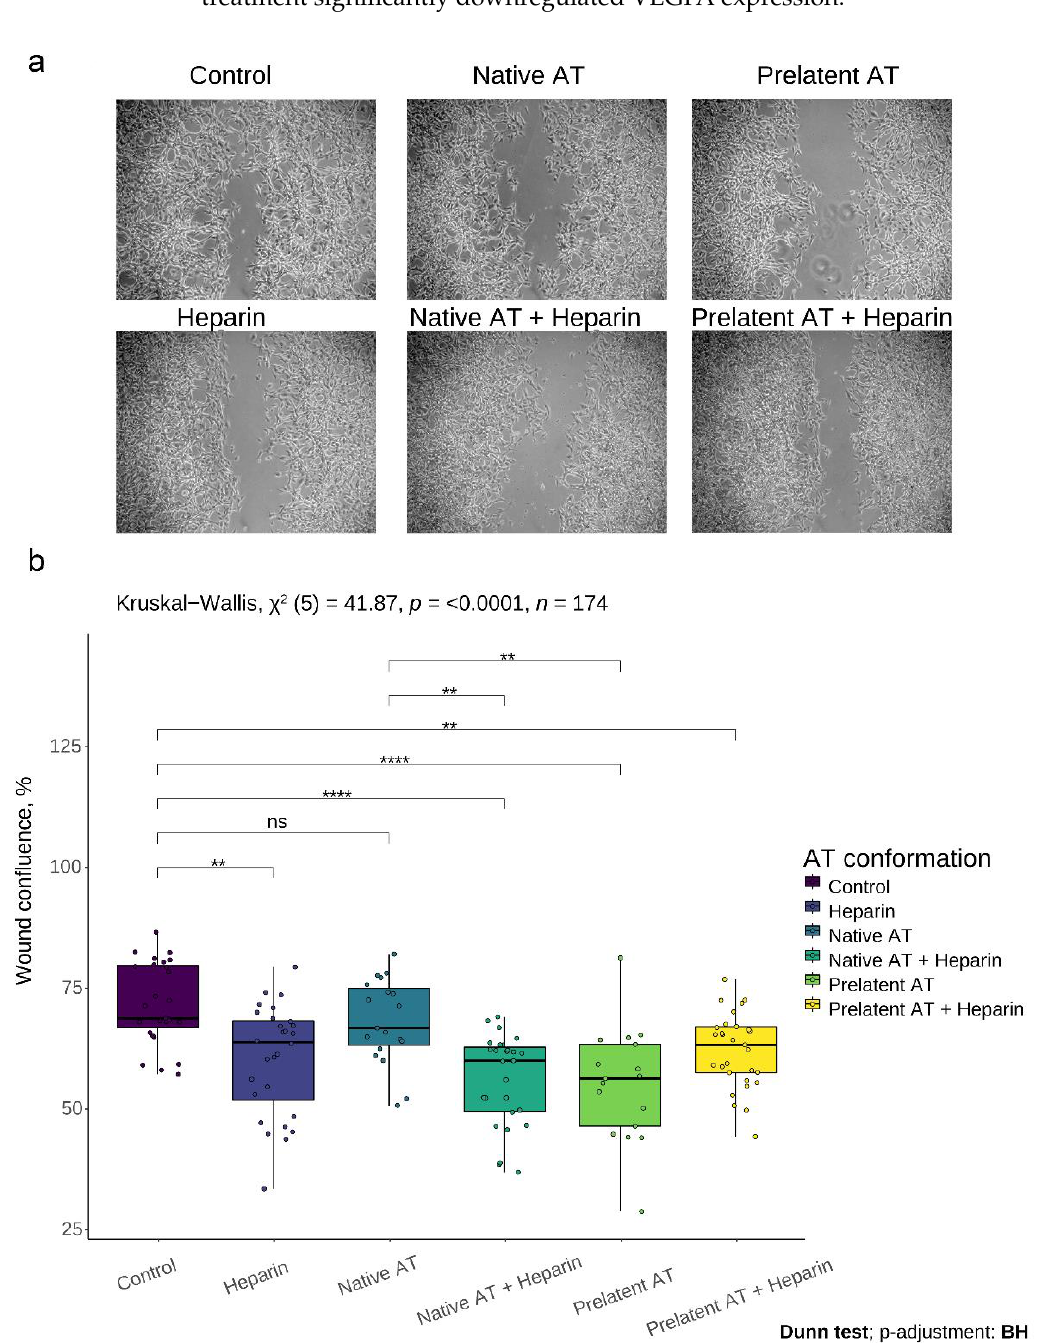
Figure 3. Effects of antithrombin on cell migration of U-87 MG cells. Wound healing was evaluated after incubation of cells for 16 h with no treatment (control), low molecular weight heparin (LMWH), native antithrombin (AT), or prelatent AT, and each AT in combination with LMWH. ( a ) Microscope images of cells 16 h after the wound created with the pipette tip. ( b ) Percentage of wound confluence under the different conditions. Each condition was evaluated in triplicate, and 5 different images were processed for each assay; ** p < 0.01; **** p < 0.0001; ns = not significant. Images were recorded with a Leica microscope at 5× and Fiji ImageJ was used to analyze migration.